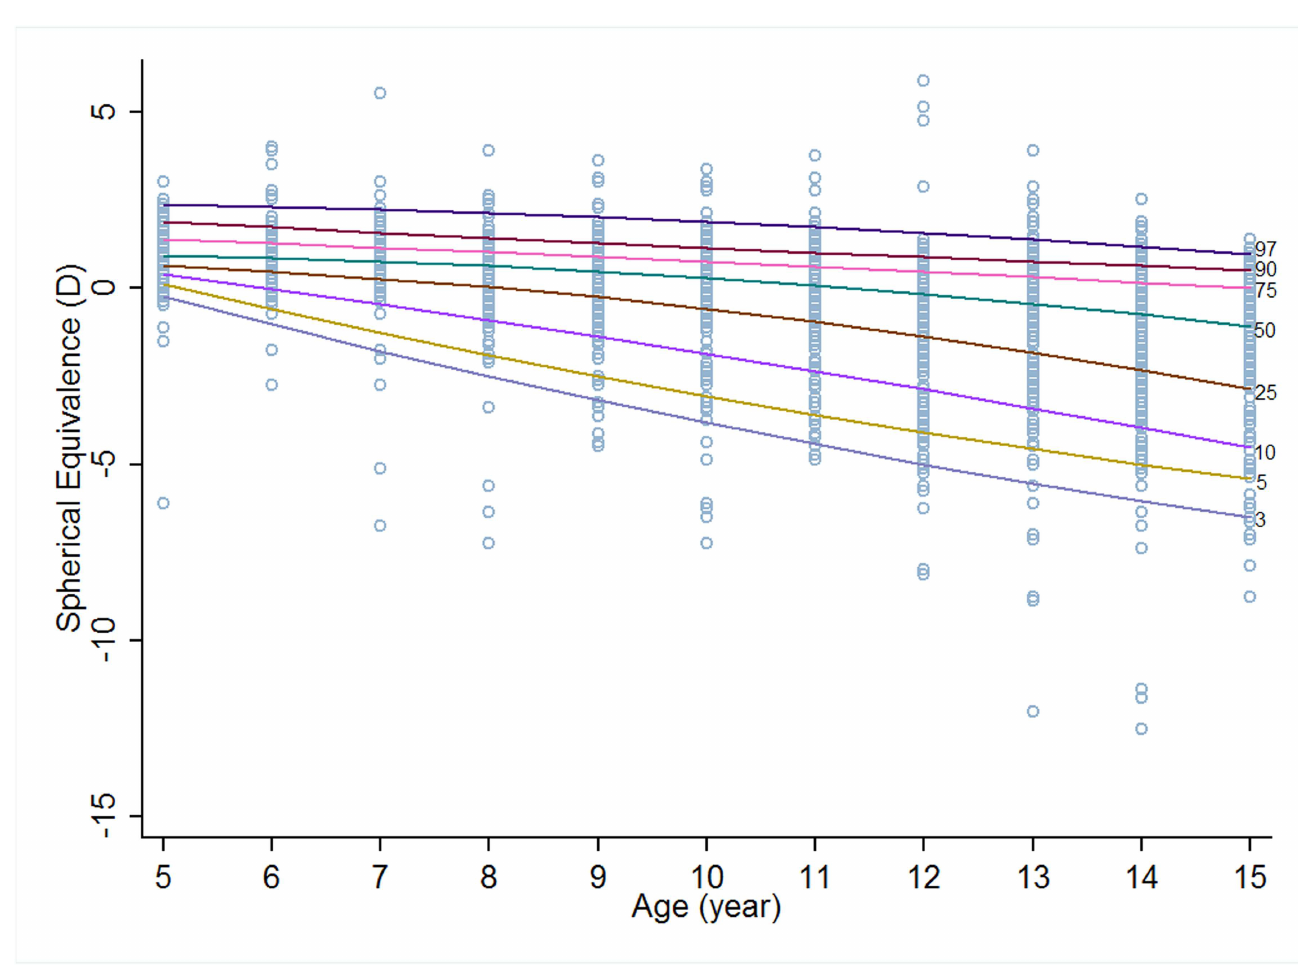
Fig 1. Percentile curves for urban Chinese boys based on cross-sectional